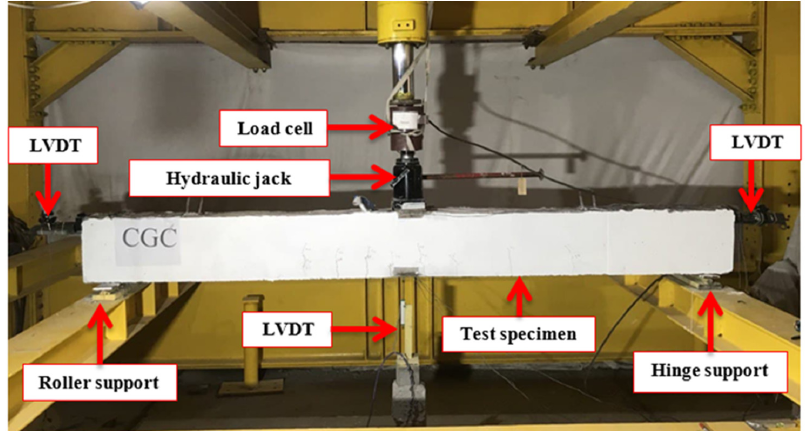
Figure 2. Test setup for static tests.